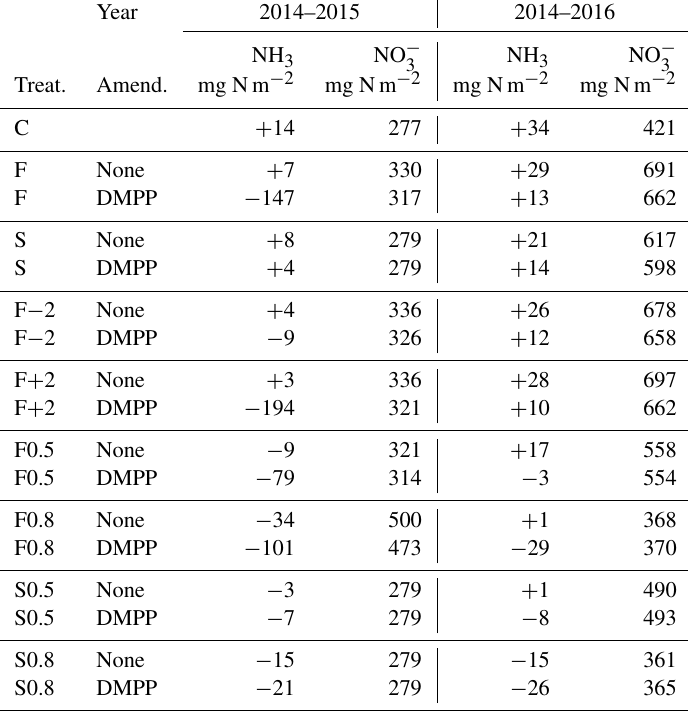
Table 7. Annual NO − discharge and NH 3 emissions modelled from 16 September to 15 September in 2014–2015 and 2014–2016 without 3 slurry (C) or with slurry applied in fall (F) or spring (S) without NI and with DMPP on dates in the field study (Table 3), in fall on dates 2 weeks before (F − 2) or after (F + 2) those in the field study, and with soil mixing during slurry application (M) increased to 0.5 and 0.8 from 0.2 in the field study. For NH 3 positive values indicate deposition, and negative values indicate emission.